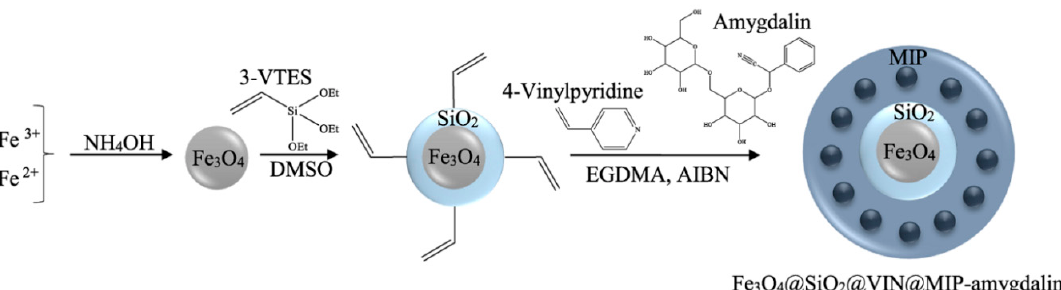
Figure 14. Scheme of Fe 3 O 4 @SiO 2 @VIN@MIP synthesis.